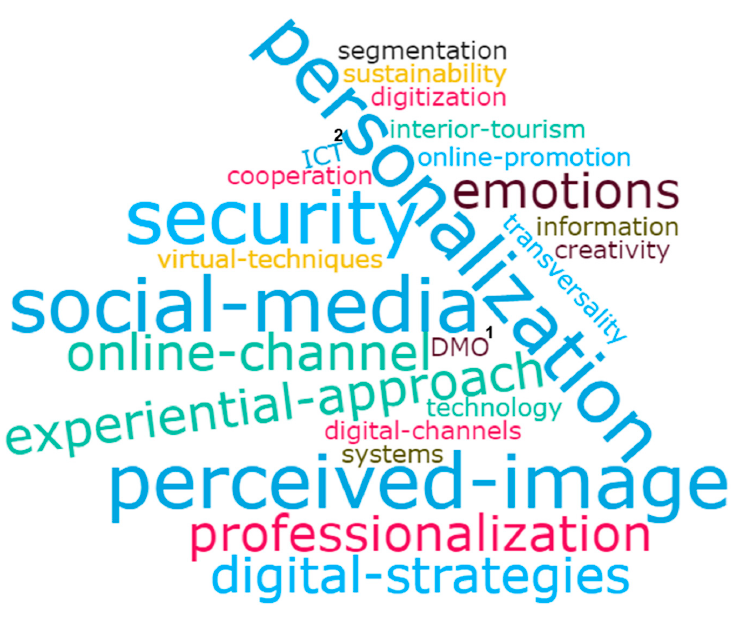
Figure 6. Expected changes in tourism promotion processes. Keywords. 1. DMO: Destination Marketing Organizatio. 2. ICT: Internet and Communication Technology.